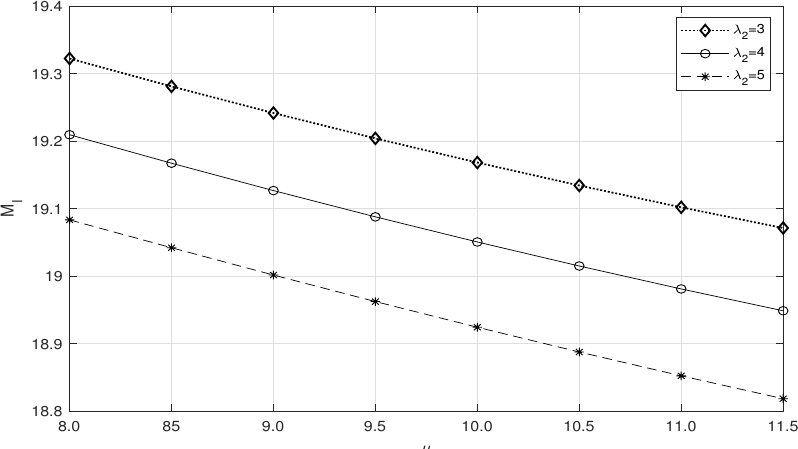
Figure 9. Mean number of items in the inventory on λ 2 vs. µ